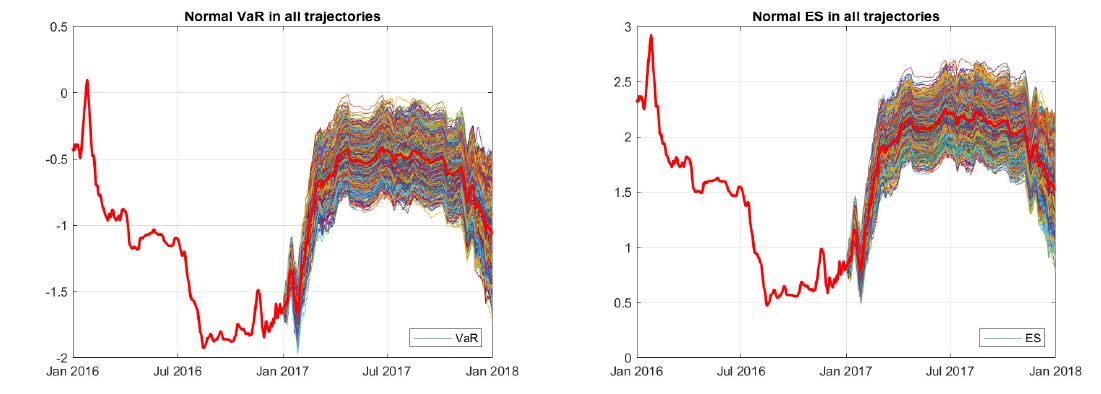
Figure 13. The simulated VaR and ES for 2017 after removing extreme tails using normal